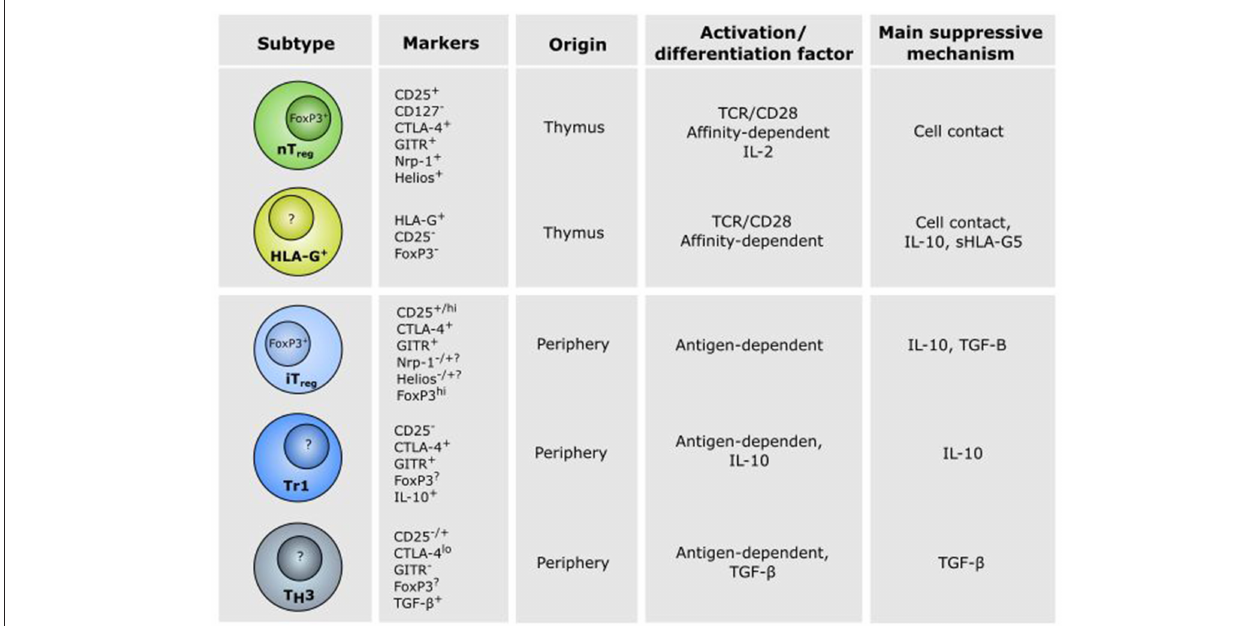
FIGURE 2 | Characteristics of CD4 + regulatory T cell subsets. Different subsets of CD4 + regulatory T (Treg) cells exist and play a role in the establishment of tolerance in different physiological and pathophysiological settings. Thymic (t)Tregs and HLA-G + Tregs are developed in the thymus in response to self-antigen, whereas induced (i)Tregs, Tr1 cells and Th3 cells are developed in the periphery in response to antigen presentation and cytokines. Natural Treg and iTregs are characterized by CD25 and FoxP3 expression, while HLA-G + Tregs, Tr1, and Th3 cells are CD25 − FoxP3 − , although controversies do exist (see the text for details). The thymus-derived Treg cells mediate their effect mainly through cell contact. In contrast, immune suppression by peripheral induced iTreg, Tr1, and Th3 cells are mediated mainly via secretion of the anti-inflammatory cytokines TGF- β and